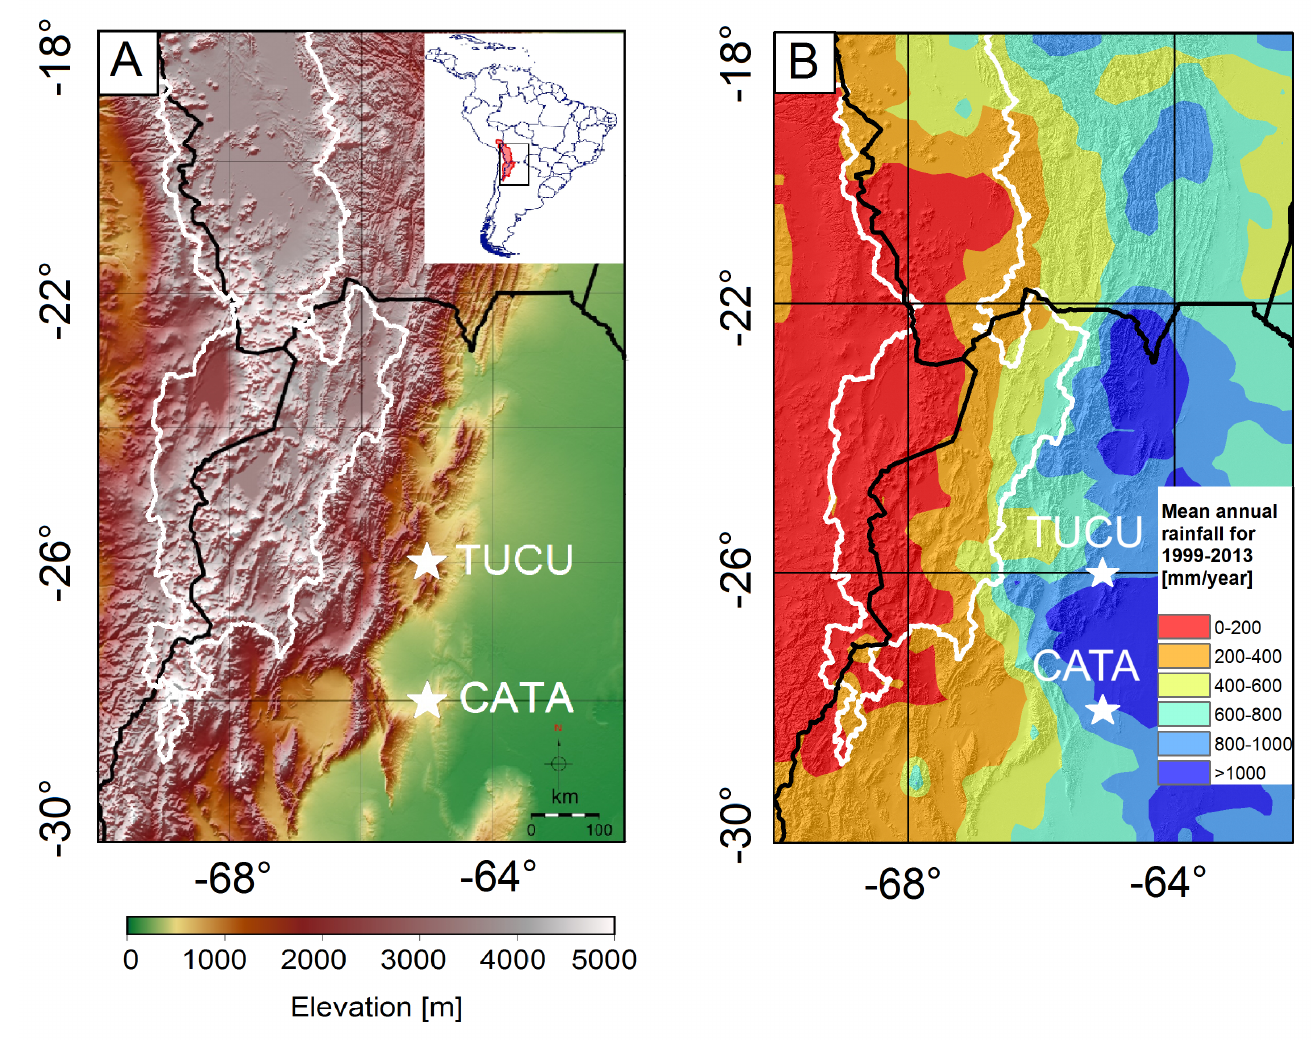
Figure 1. ( A ) Topographic overview (from [45] data) of the study region in the central Andes in north-western Argentina with the outline of the internally-drained central Andes in white (see inset for location in South America with the internally- drained central Andes shown in red). Black lines are international borders. White stars show the GNSS stations used in this study: San Miguel de Tucumán (TUCU, n = 15 years) and San Fernando del Valle de Catamarca (CATA, n = 6 years). ( B ) Annual mean rainfall derived from TRMM 3B42 (1999–2013) shows rainfall distribution and the location of the GNSS station locations (white